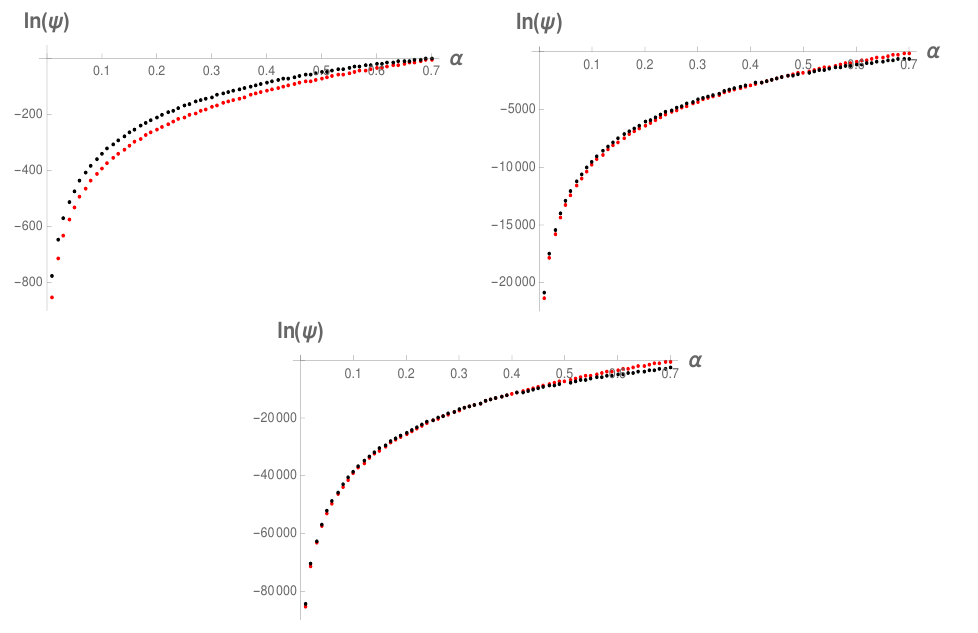
Figure 1 . Comparison of eq. (6.4) (red) versus the exact matrix elements calculated using the Van- dermonde formula (6.3) (black) at N = 20 (top left), N = 100 (top right) and N = 200